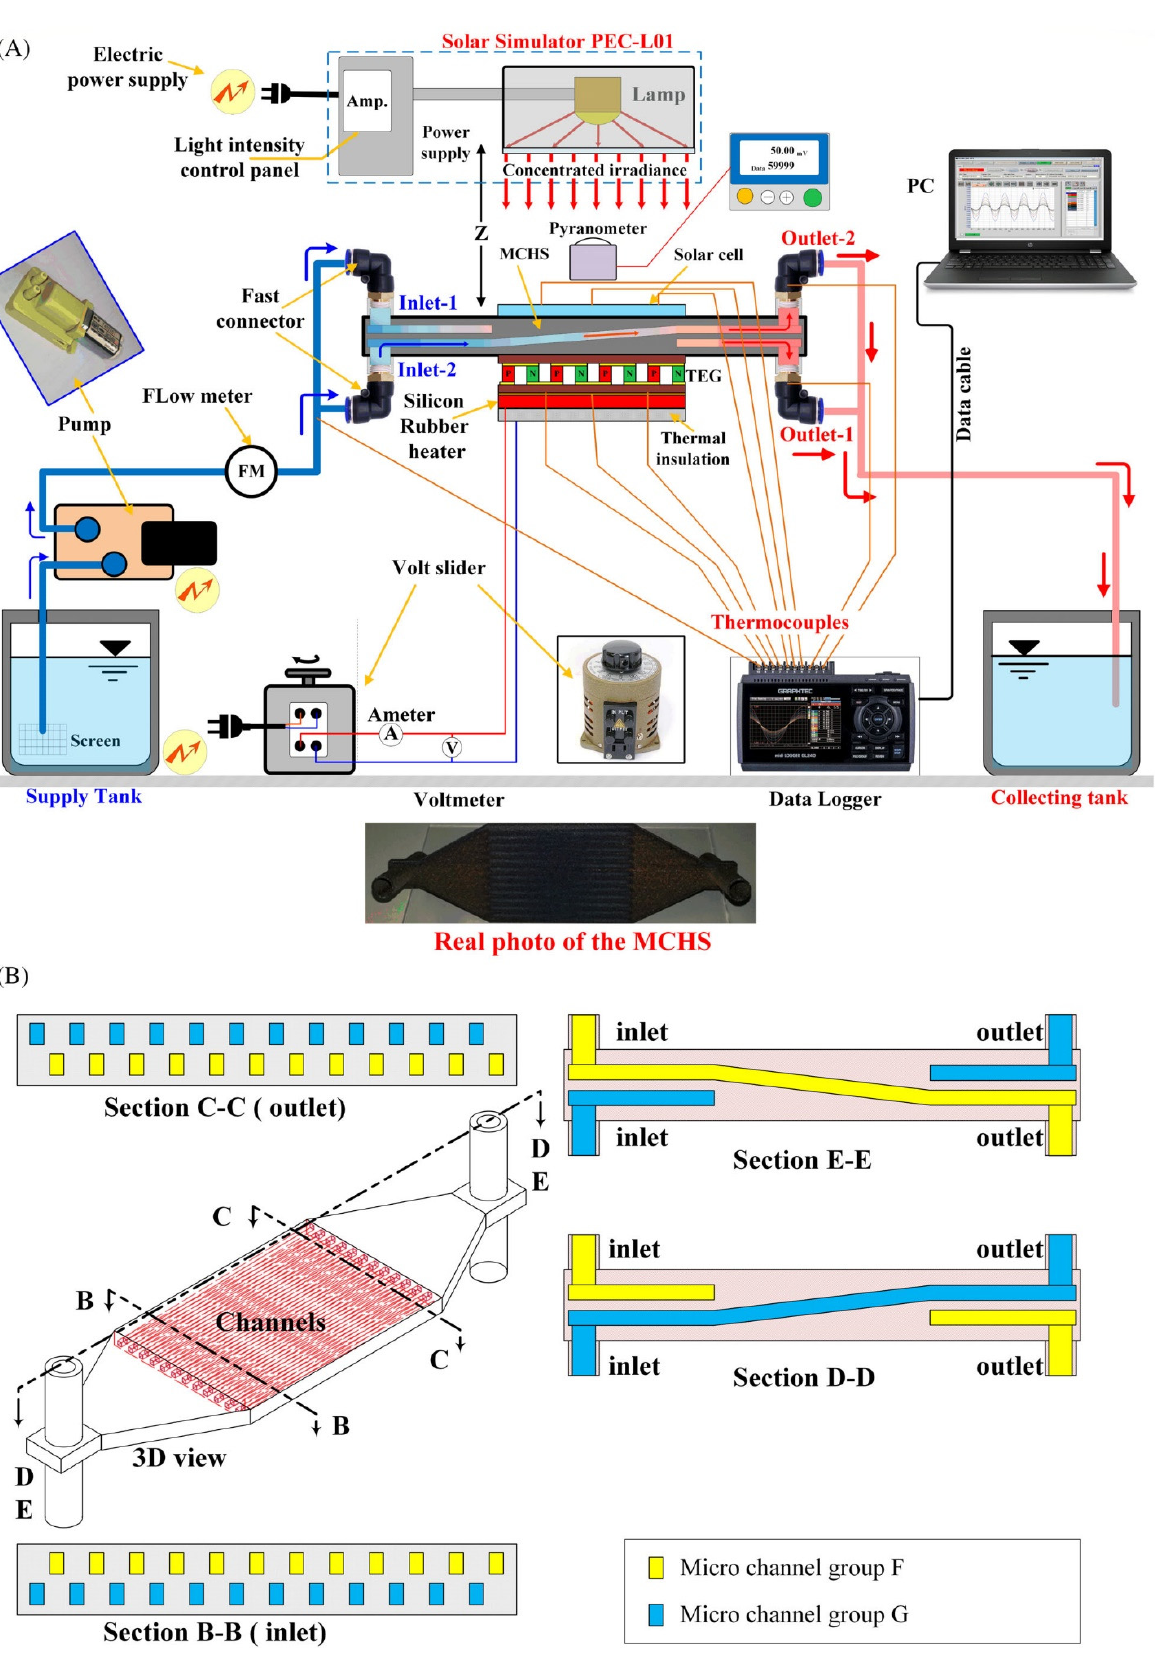
Figure 14. PV microchannel TEG System. Schematic of: ( A ) the experimental setup; ( B ) the 3D metal printed microchannel heat exchanger. Reprint with permission [81]; Copyright 2021, JOHN/WILEY & SONS LTD.